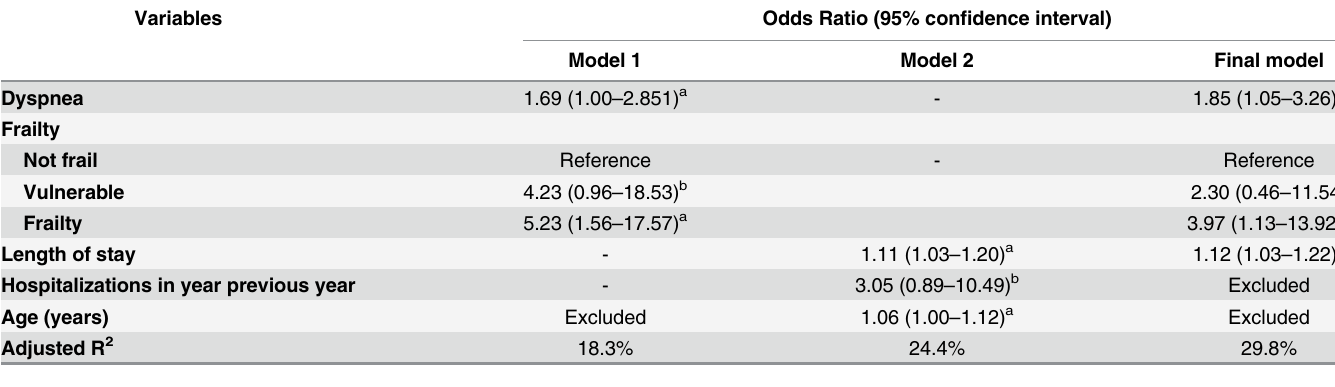
Table 3. Predictors of Functional Decline at Week 12 after Hospital